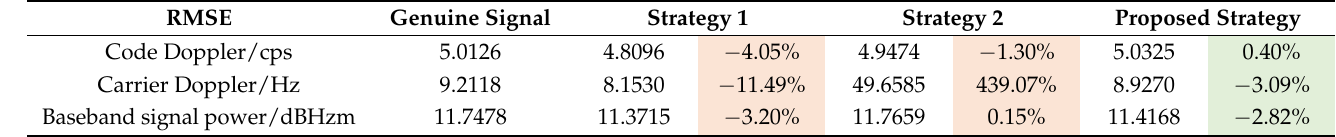
Table 5. Comparison of RMSE for different strategies and the genuine signal (C/N 0 = 40 dBHz, D = 1). RMSE Figure 21. Ratio Test metric behavior of the genuine signal.